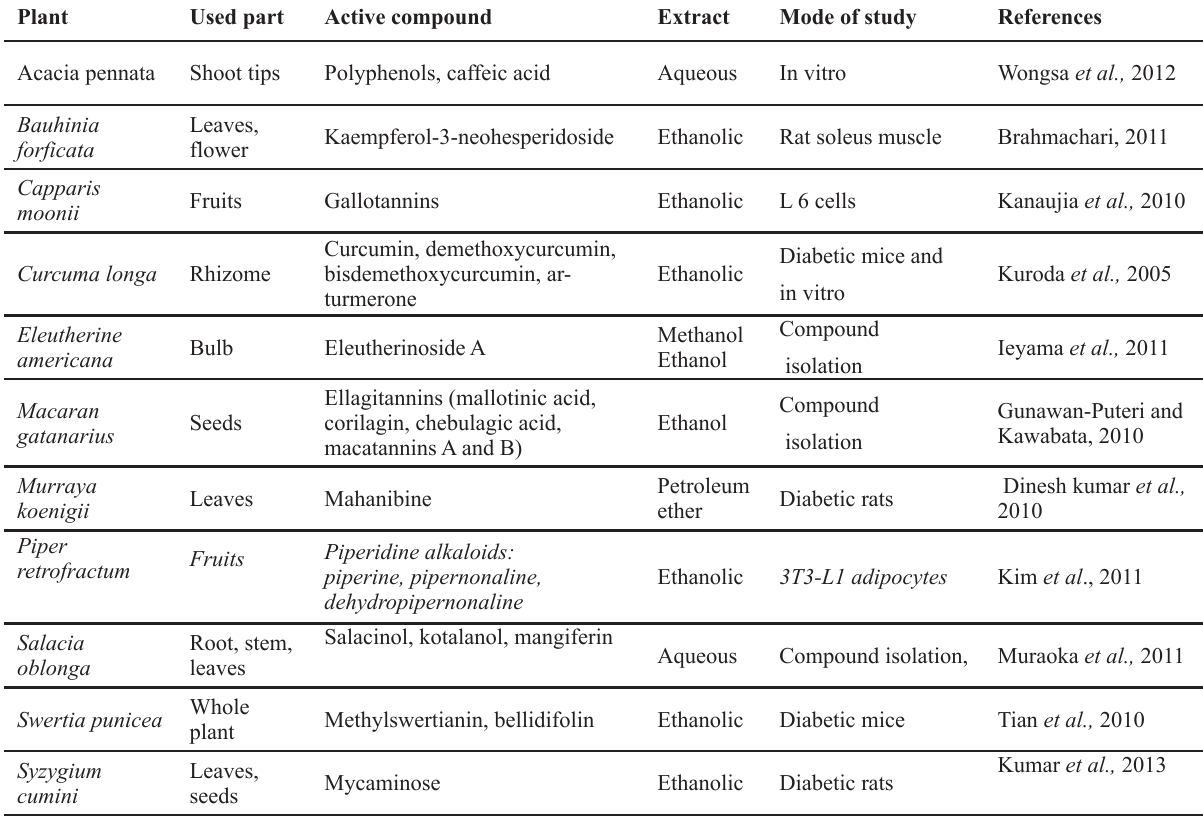
Table 2: Reported antidiabetic active compounds isolated from medicinal plants.